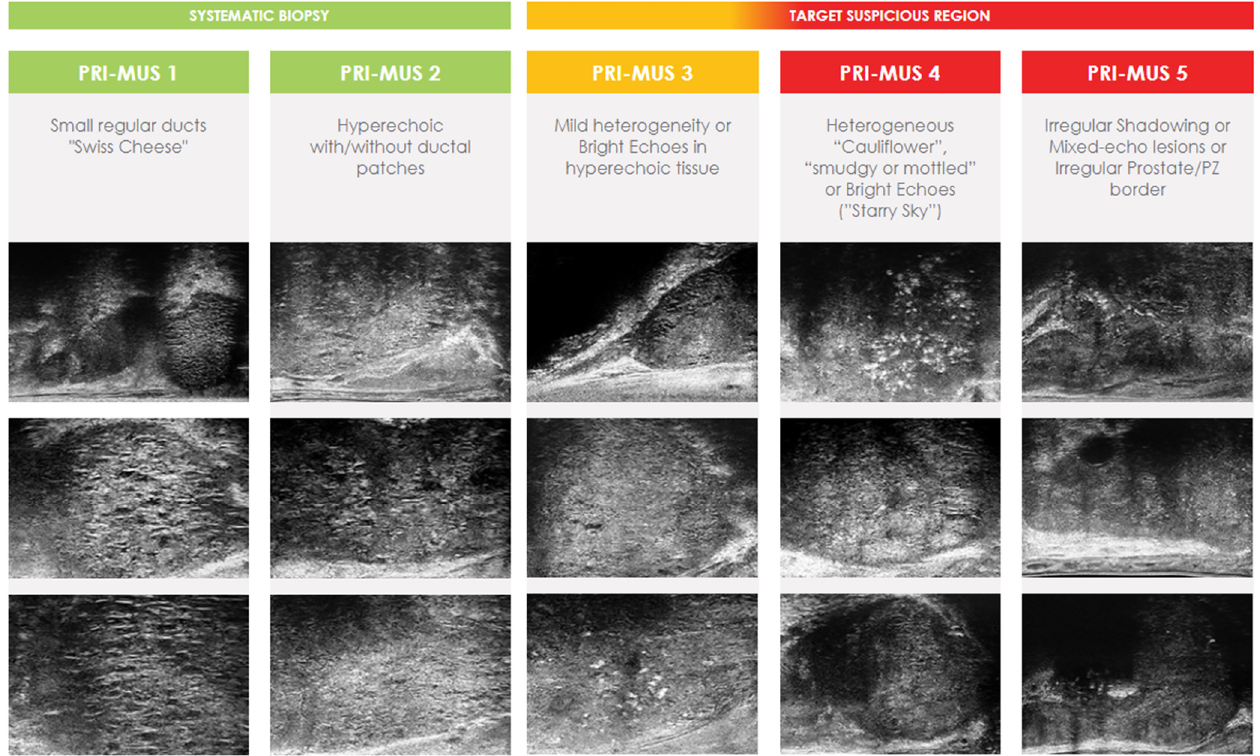
Figure 2. Official examples of ExactVu™ system PRI-MUS grades, from https://www.exactimaging.com (accessed on 17 January 2022); Images provided courtesy of Exact Imaging. Scale bar or magnification.